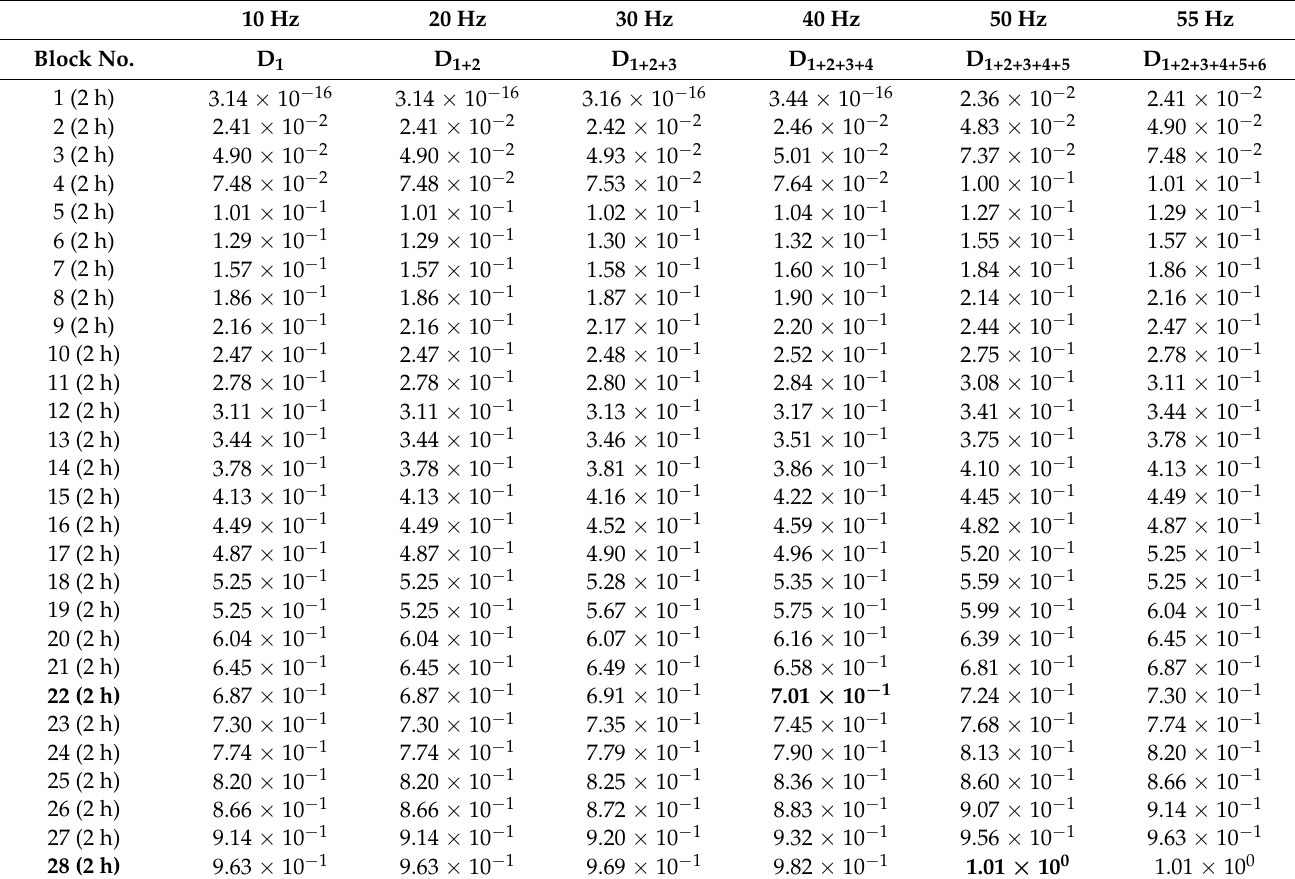
Table 7. Cumulative damage calculation using proposed nonlinear